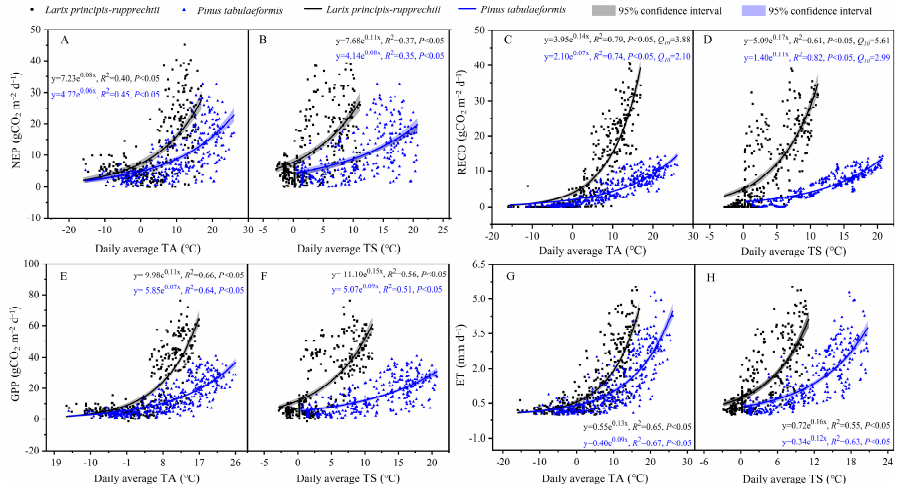
Figure 5. The regression relationship between the daily CO 2 /H 2 O fluxes (NEP (negative NEE), RECO, GPP, and ET) and daily environmental factors (air temperature (TA), soil temperature (TS)) in two forest ecosystems. ( A – H ) indicate different small panels. 3.5. Annual Variations of Water Use Efficiency and Light Use Efficiency in Two Forest Ecosys- tems The relationships between GPP and ET, between GPP × VPD 0.5 and ET, and between GPP and PAR were established to compare the water use efficiency (WUE), underlying water use efficiency (uWUE), and light use efficiency (LUE) in two forest ecosystems (Fig- ure 6). Both GPP and GPP × VPD 0.5 increased linearly with ET, and GPP also showed the same trend with PAR. The WUE and uWUE of the L. principis-rupprechtii forest ecosystem were 3.45 g C·kg − 1 H 2 O and 2.70 g C·KPa 0.5 ·kg − 1 H 2 O, higher than those of the P. tabu- laeformis forest ecosystem (2.08 g C·kg − 1 H 2 O and 2.42 g C·KPa 0.5 ·kg − 1 H 2 O) (Figure 6A,B). The LUE of the L. principis-rupprechtii and P. tabulaeformis forest ecosystems was 0.10 and 0.06 g C·d·W − 1 (Figure 6C).